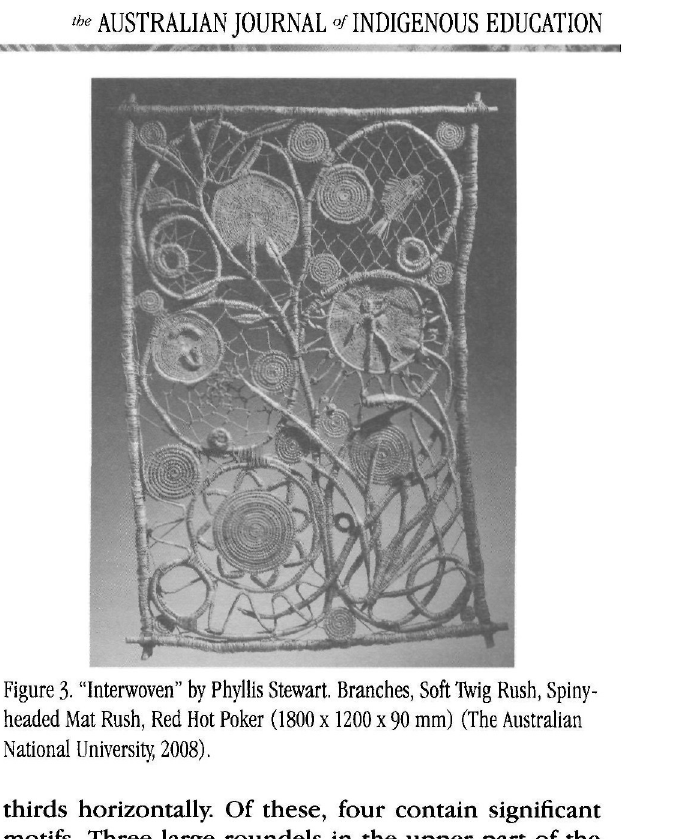
Figure 3- "Interwoven" by Phyllis Stewart. Branches, Soft Twig Rush, Spiny- headed Mat Rush, Red Hot Poker (1800 x 1200 x 90 mm) (The Australian National University,